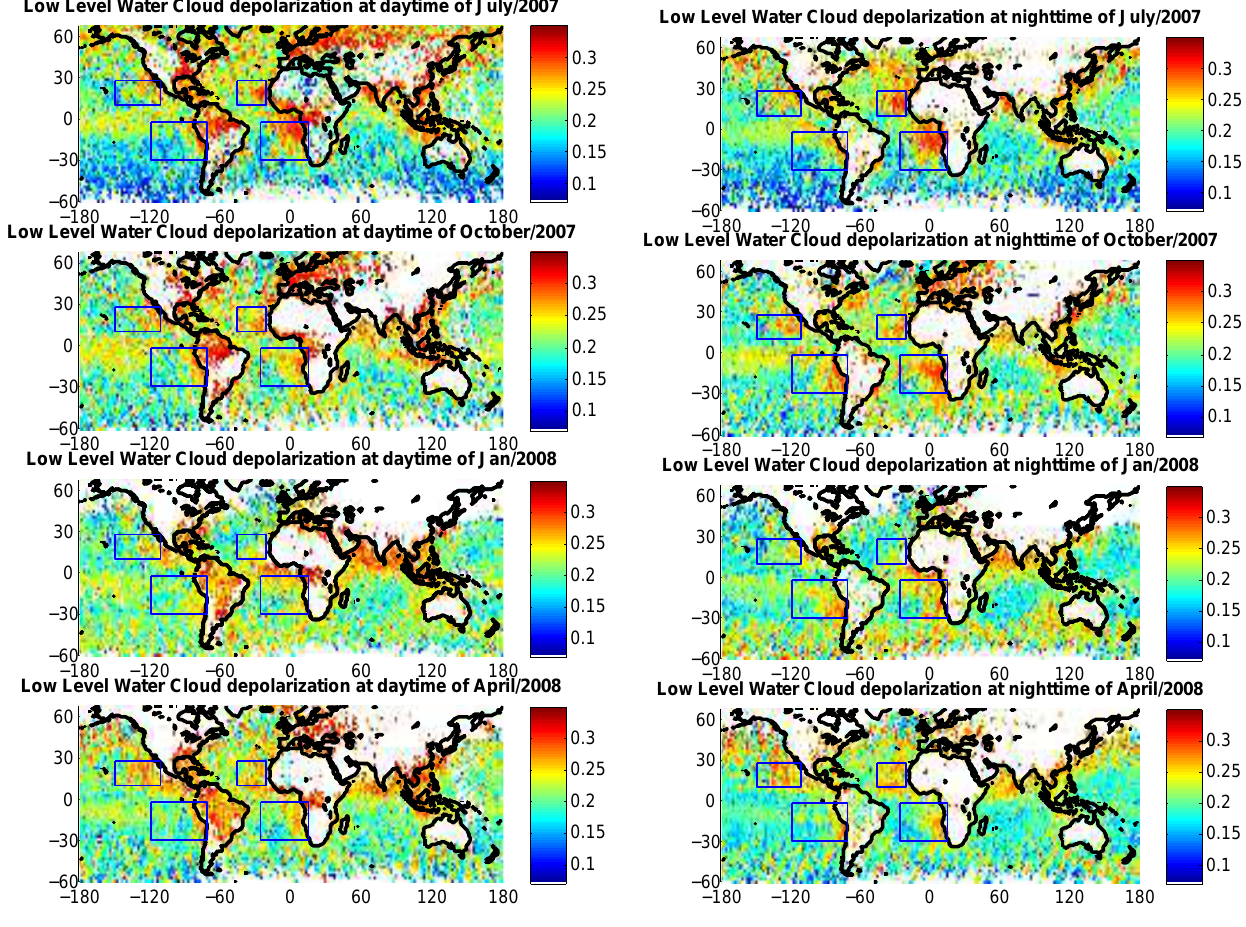
Fig. 7. The global distribution (2 ◦ by 2 ◦ ) of Low level water cloud depolarization ratio at different months CALIPSO level-2 333m cloud products. The left panel is for daytime; the right panel is for nighttime. Individual Sc regions are outlined in blue boxed and are identified in Fig. 6 and listed in Table 1.